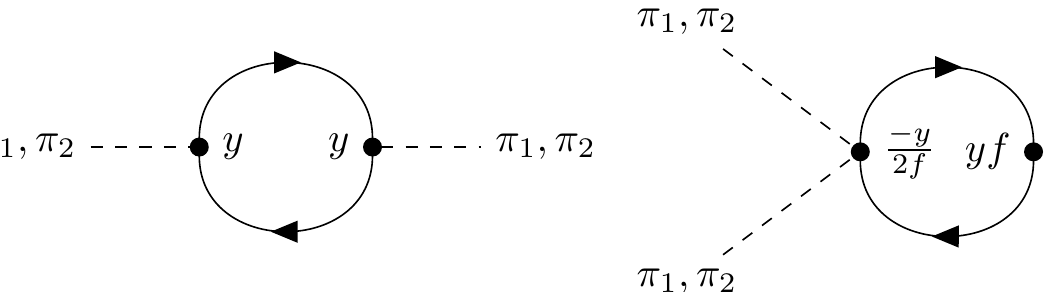
Figure 1. The two quadratically divergent one loop diagrams for pion mass that cancel each other